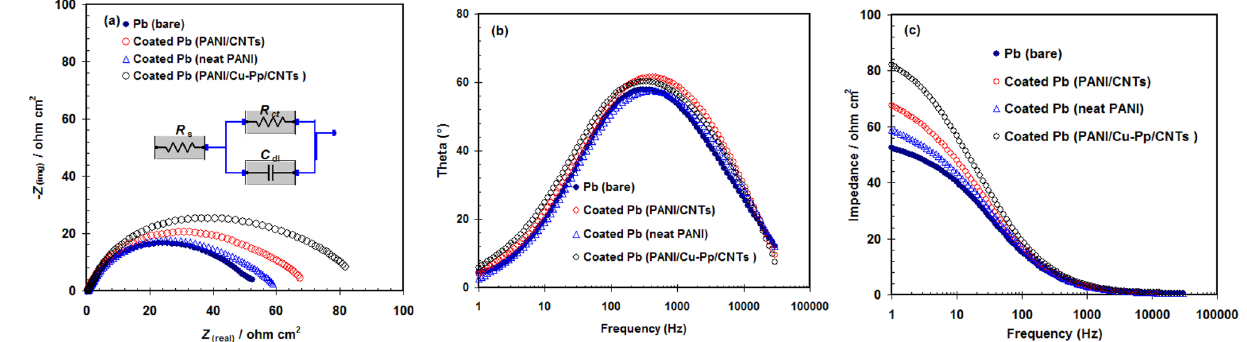
Figure 5. EIS plots (Nyquist ( a ), Bode ( b ) and Phase angle ( c ) plots) for bare Pb, coated Pb (neat PANI), coated Pb (PANI/CNTs) and coated Pb (PANI/Cu-Pp/CNTs ) in 5.0 M H 2 SO 4 at − 1.1 V vs. Hg/Hg 2 SO 4 and 298 K.